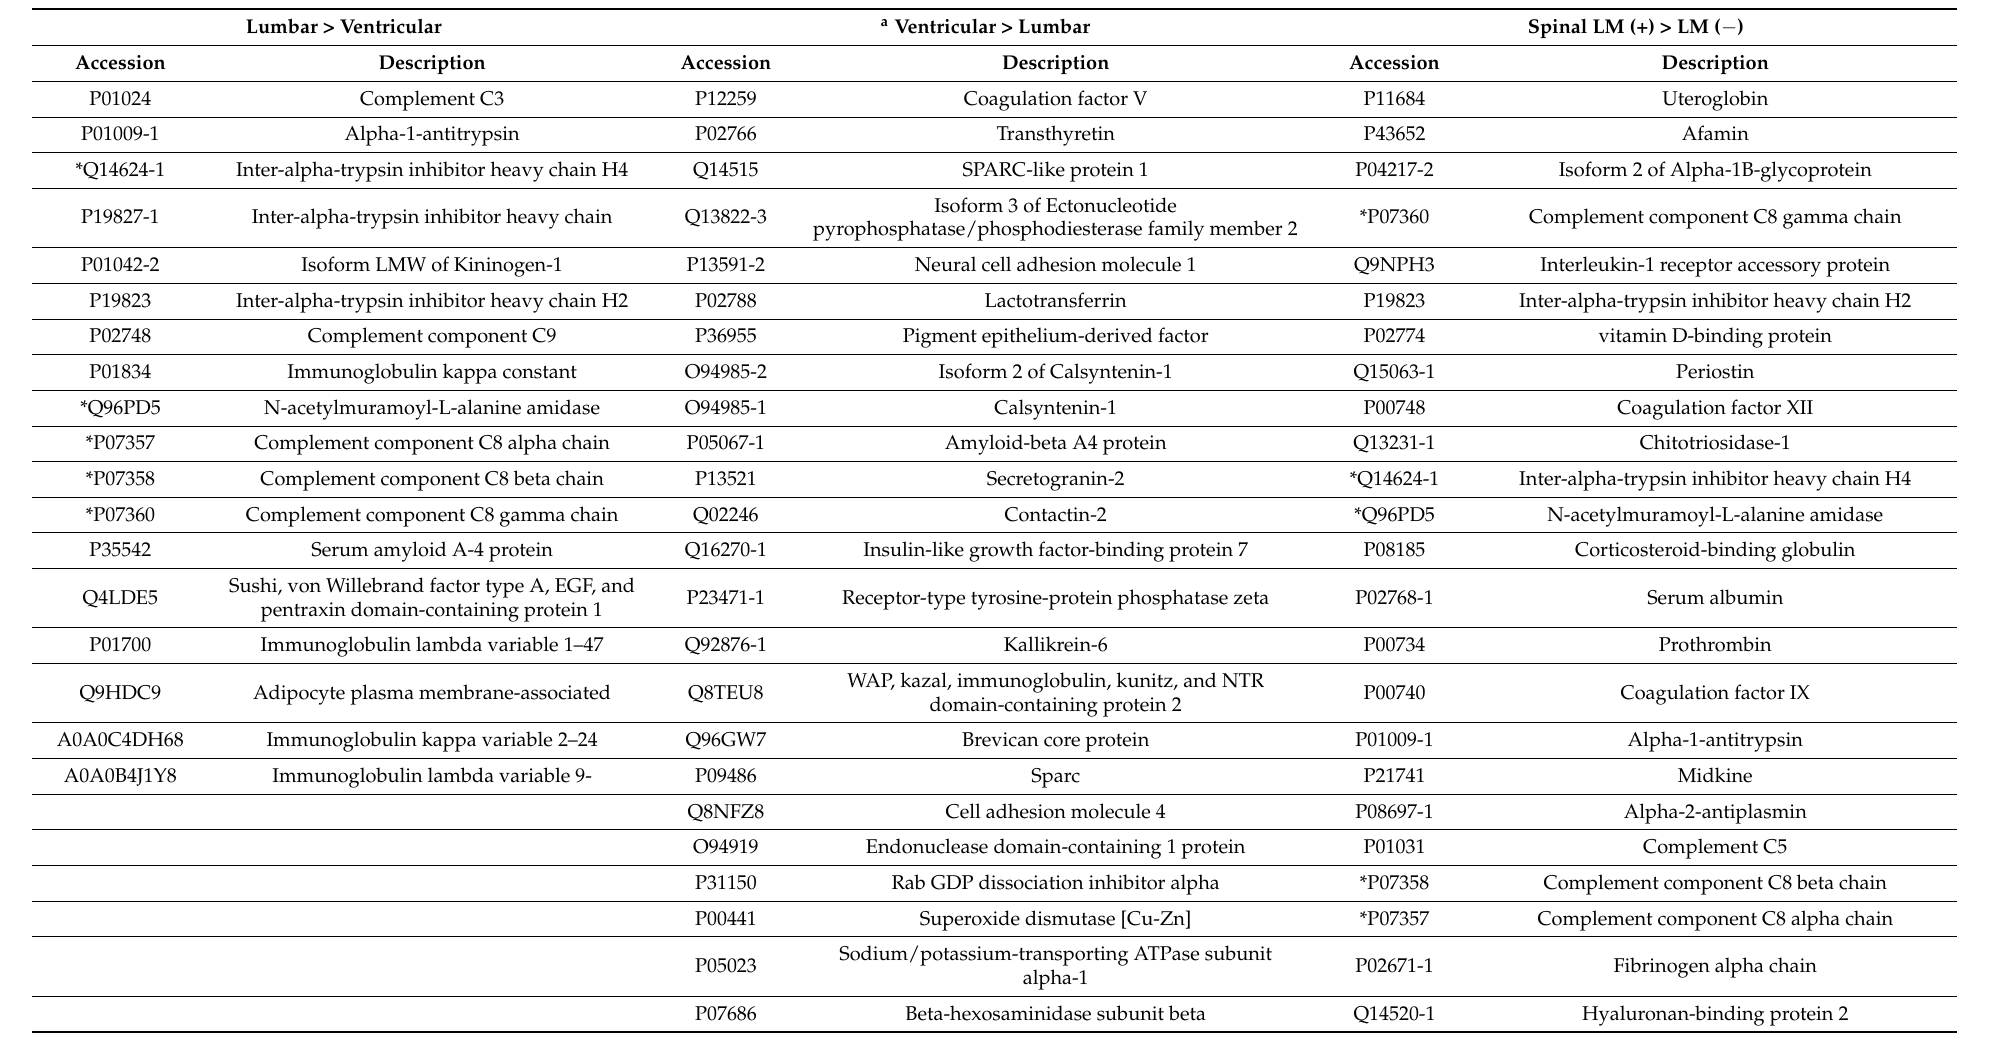
Table 6. Discriminative proteins that expressed higher in all lumbar CSF compared with paired ventricular CSF and that expressed higher in spinal LM (+) CSF compared with LM ( − )